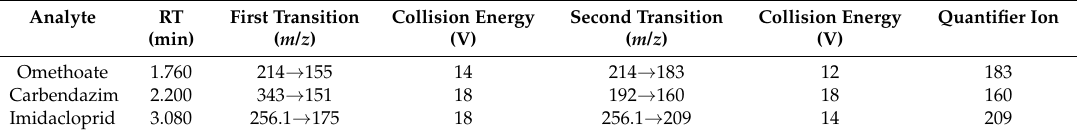
Table 2. Optimized ultra performance liquid chromatography tandem mass spectrometer (UPLC-MS/MS) parameters for the selected